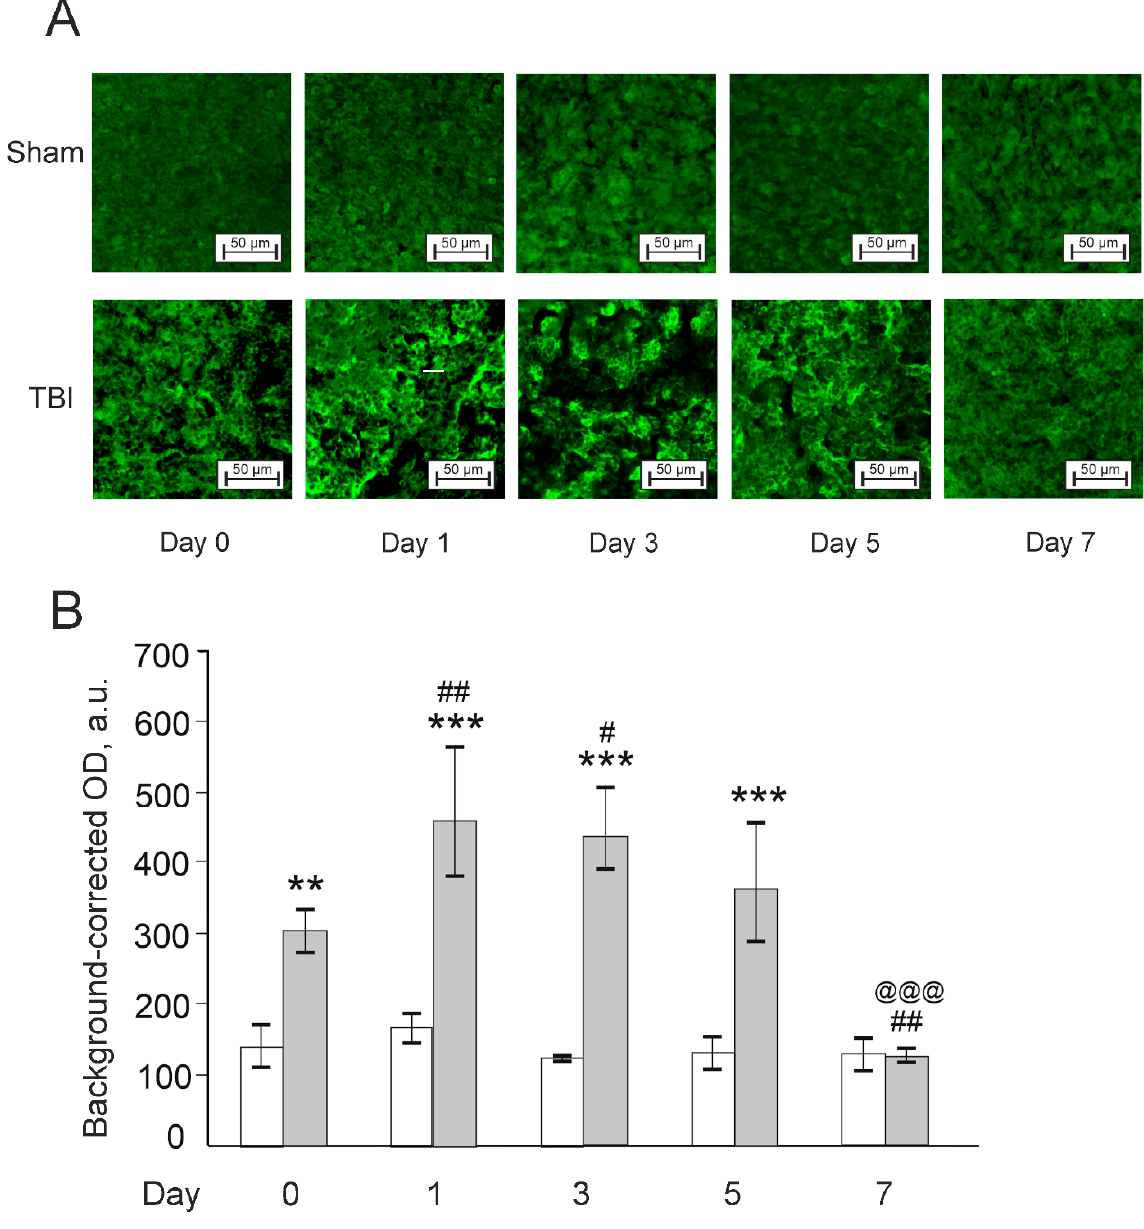
Figure 9. Effects of laser-induced lesion (TBI model) on the expression of Hif1a in zebrafish telen- cephalon on Day 0 (30 min after the lesion), Days 1, 3, 5, and 7 after the injury. ( A ): Representative images of Hif1a immunoreactivity in the telencephalon; magnification, ×200. ( B ): Quantitative results. White bars represent Sham groups, grey bars TBI groups. Data are expressed as mean ± SEM ( n = 3–4 per group). ** p < 0.01, *** p < 0.001 vs. Sham group on the same day after the injury; # p < 0.05, ## p < 0.01 vs. TBI group on Day 0; @@@ p < 0.001 vs. TBI group on Day